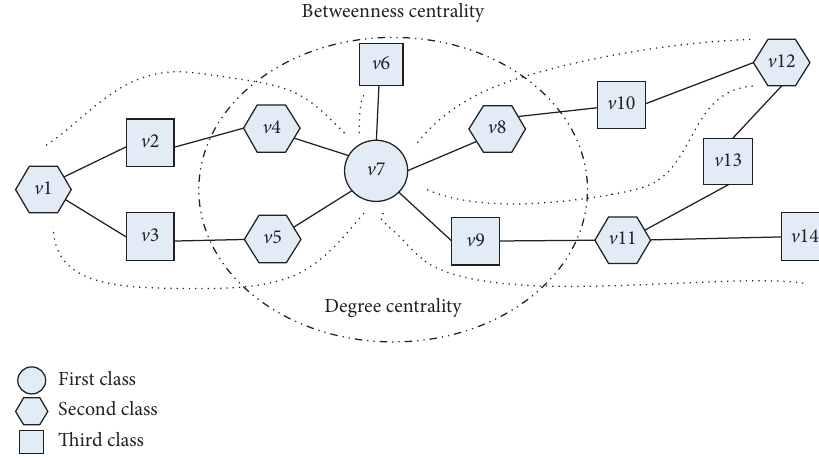
Figure 1: Diagram of component impact